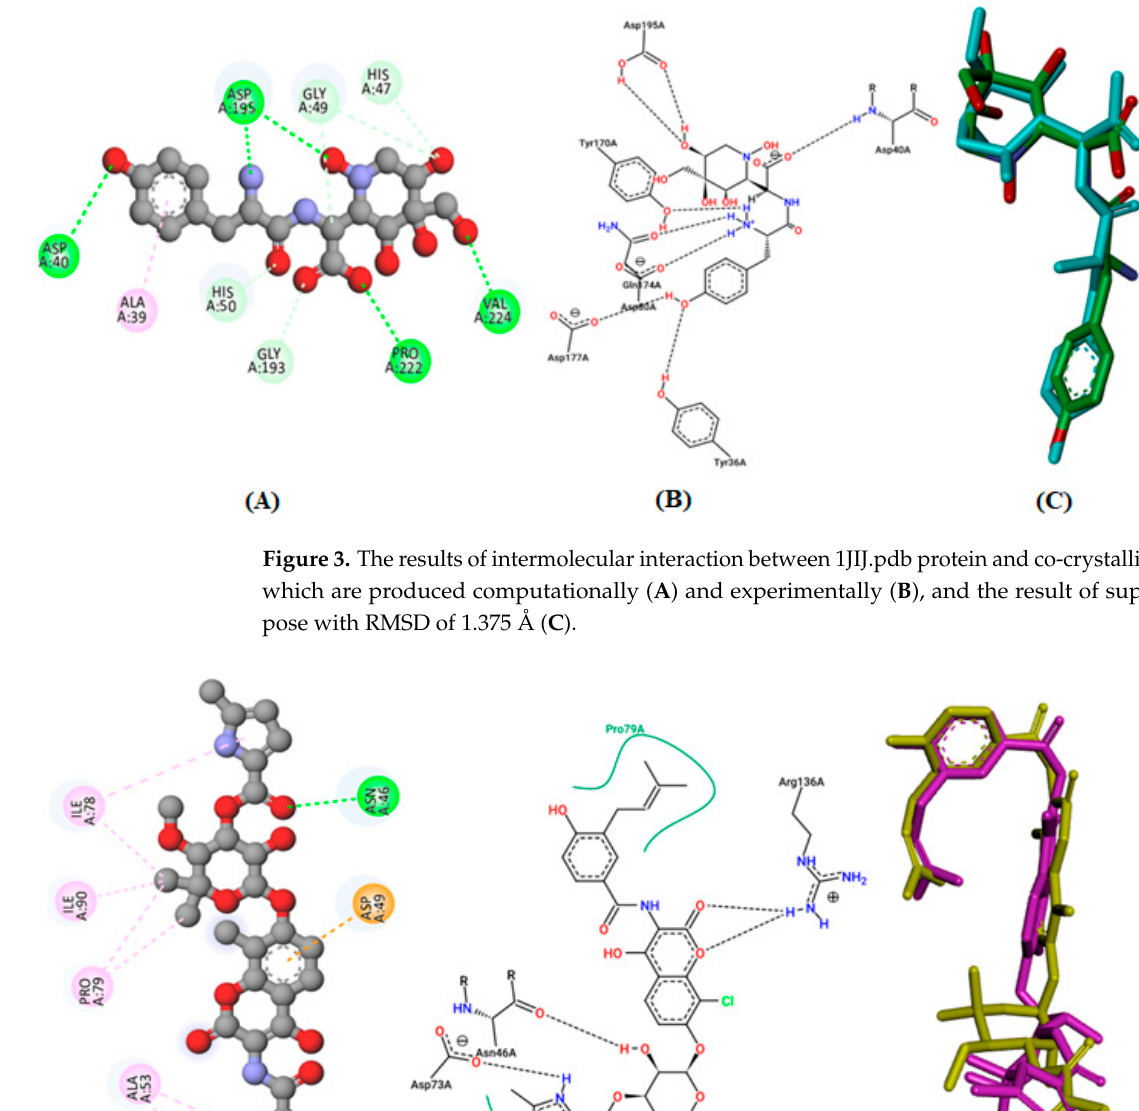
Figure 4. The results of intermolecular interaction between 1KZN.pdb protein and co-crystallized ligand, which are produced computationally ( A ) and experimentally ( B ), and the result of superposition pose with RMSD of 1.987 Å ( C ).